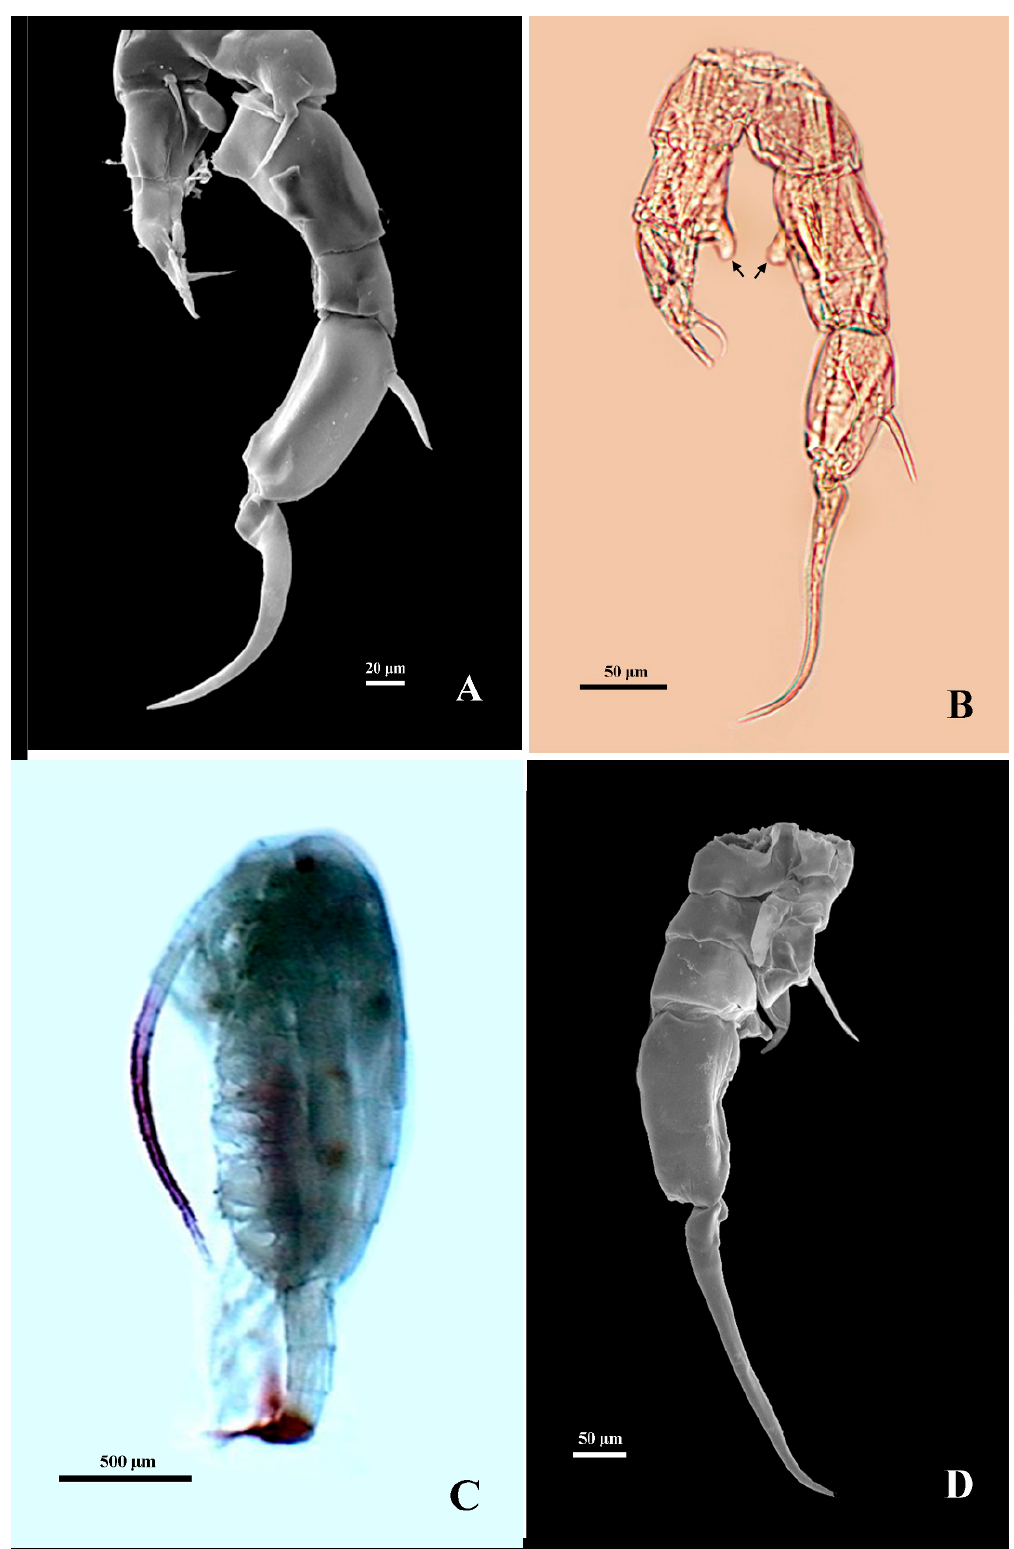
Figure 5. Photographs of three species of diaptomid copepods. ( A ) male P5 of Heliodiaptomus phuthaiorum ; ( B ) male P5 of Arctodiaptomus sp. (black arrows point to left and right hyaline membranes on left and right bases; ( C ) habitus of male Paradiaptomus greeni ; ( D ) male P5 of P. greeni .